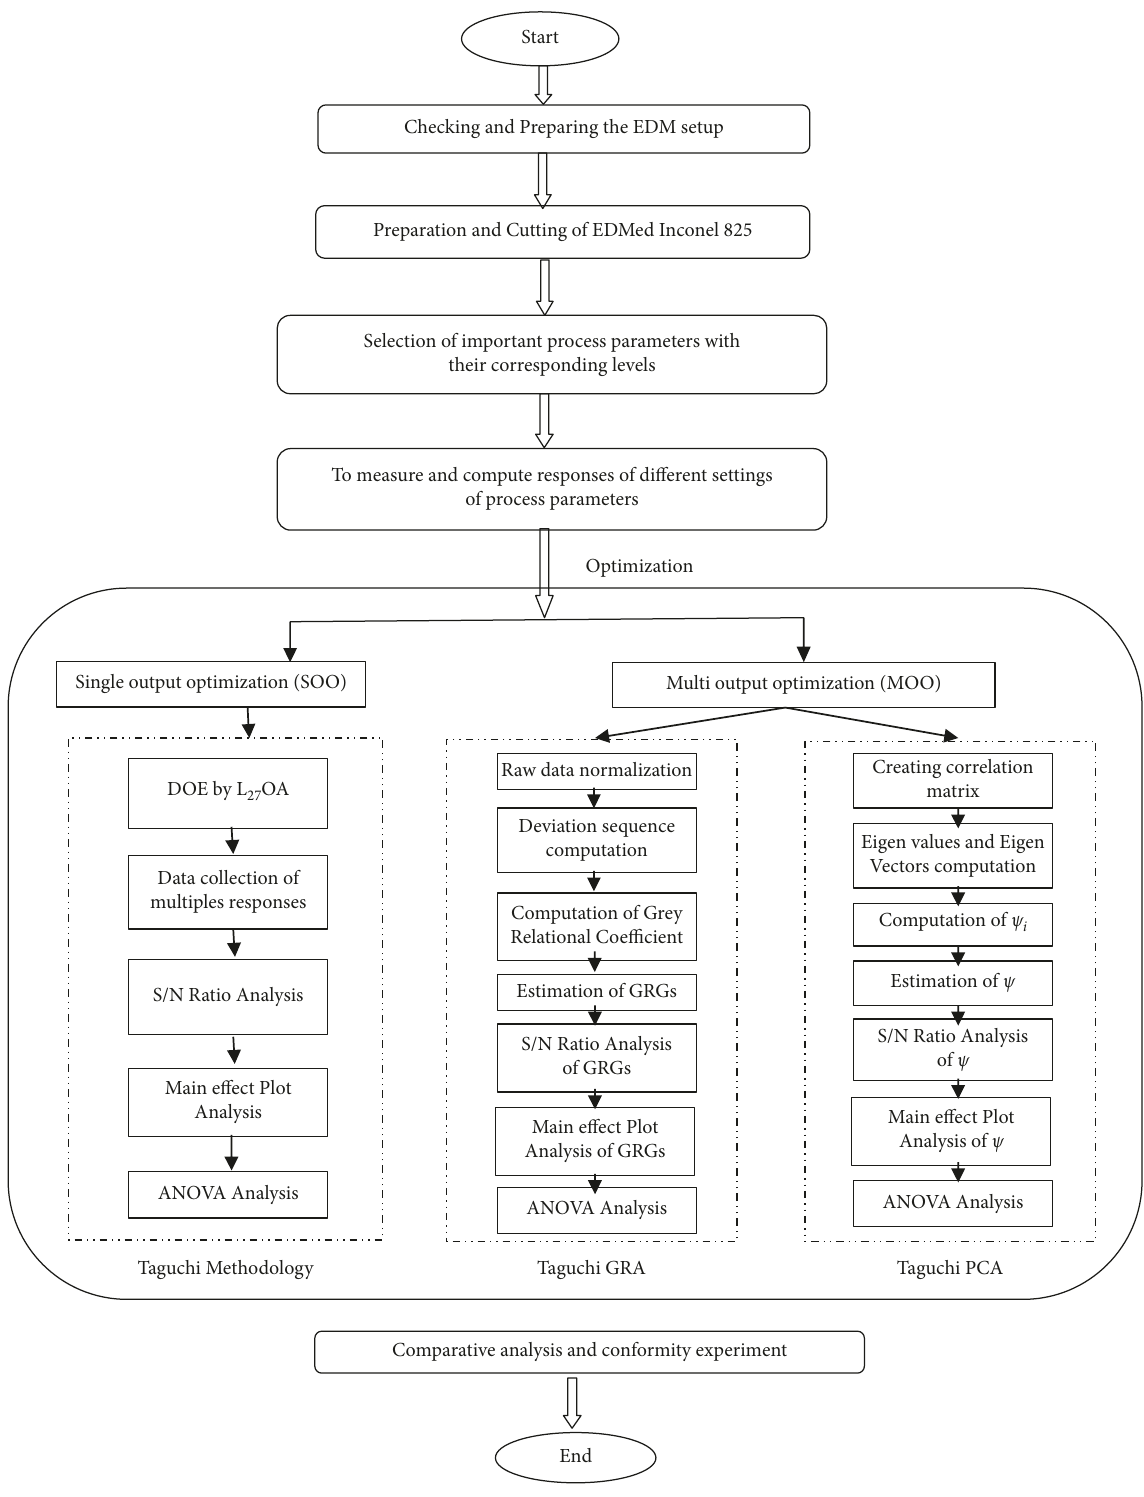
Figure 3: Flow chart of conducted experimental research for EDMed Inconel 825